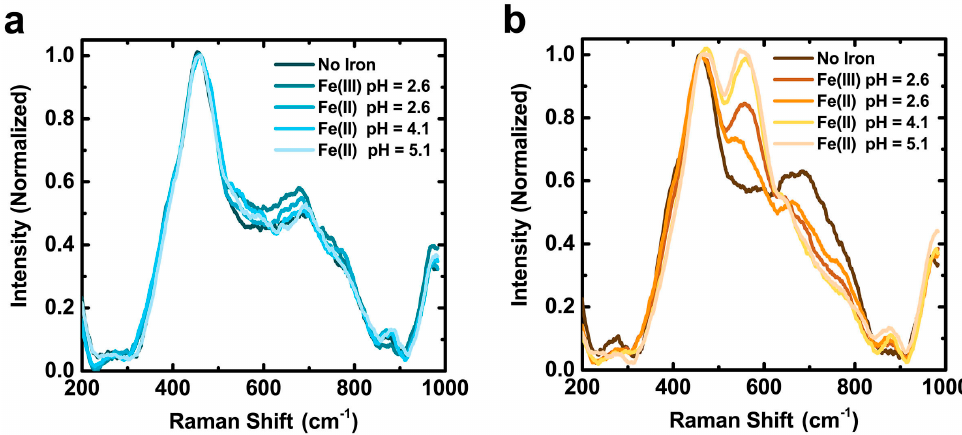
Figure 6. Raman spectra of PDA films before and after incubation in 5 mM ferric or ferrous chloride solutions for 100 min, labeled as Fe(III) or Fe(II), respectively: ( a ) Pristine PDA films; and ( b ) PDA films that were incubated in in 300 mM CaCl 2 50 mM Tris buffer pH = 9.5 for 4 h. The band centered at 460 cm − 1 corresponds to –OH torsion. The band at 555 cm − 1 visible in ( b ) is due to vibration of the 200 and 2000 cm − 1 and quantification of band